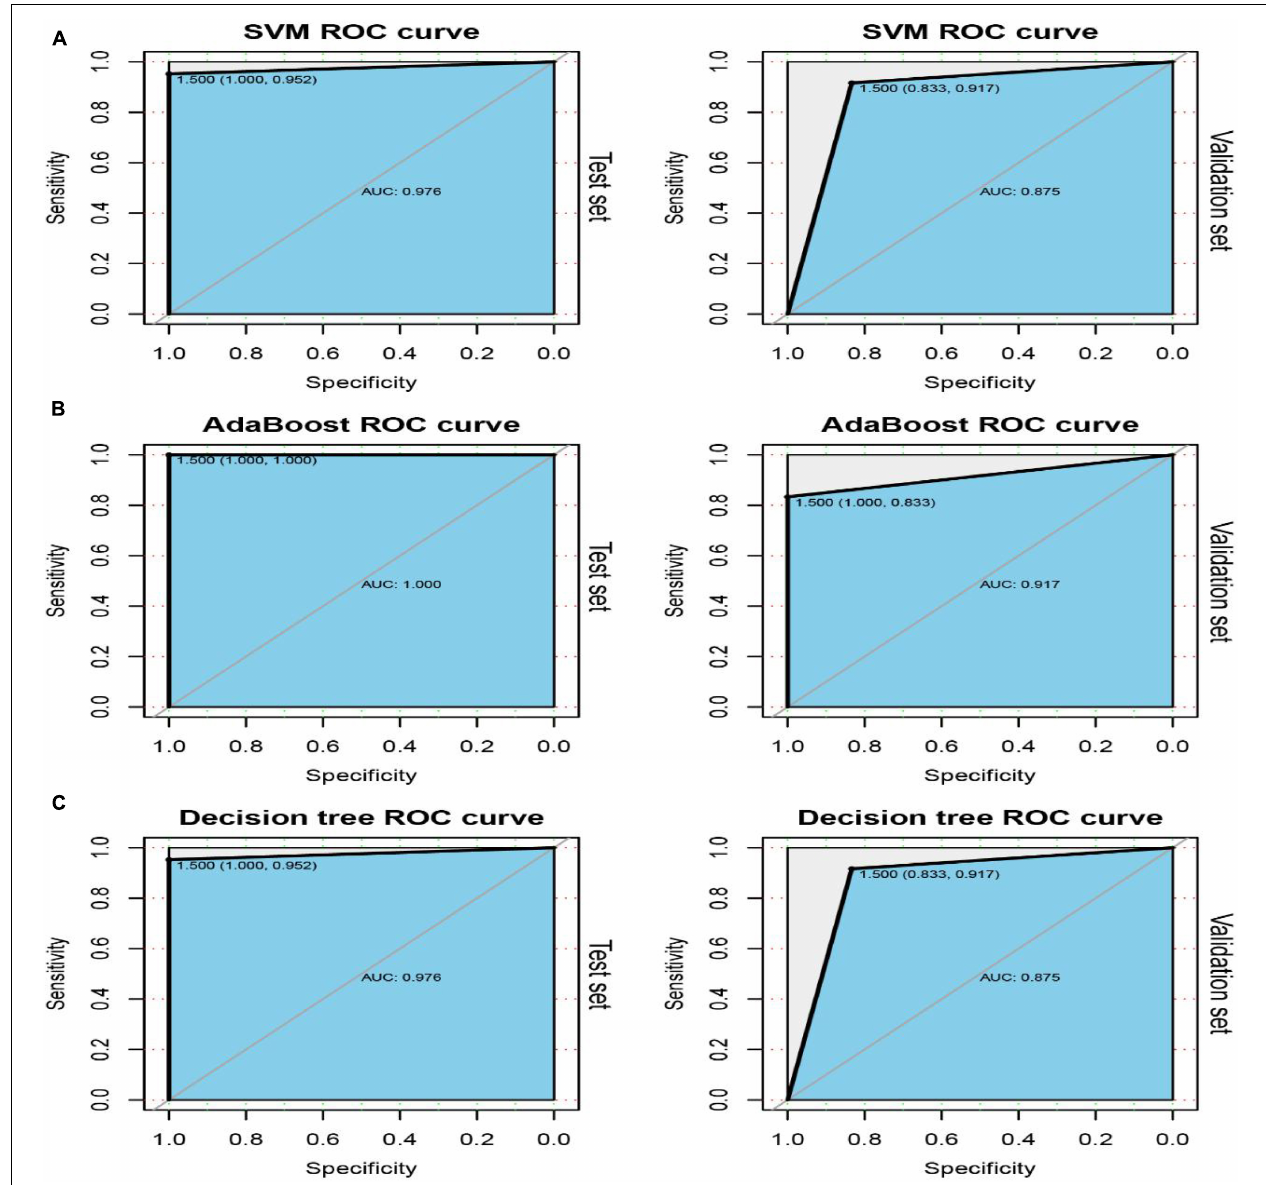
FIGURE 8 | ROC curves of the test and validation sets of three classifiers: SVM (A) , AdaBoost (B) and Decision tree (C)